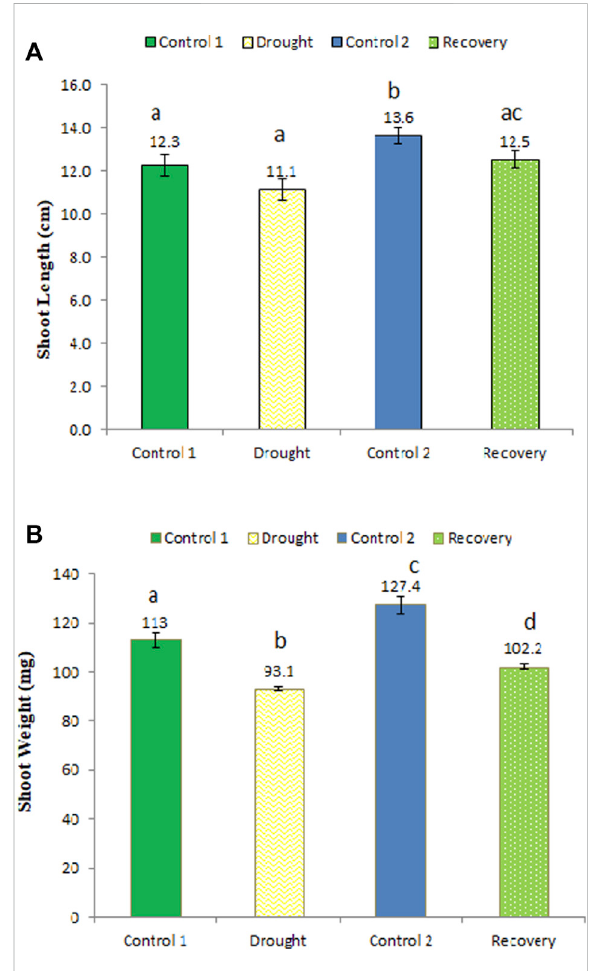
FIGURE 3 Effectofdroughtstressontheshootlength (A) andweight (B) of wheat and its recovery after drought stress. Length is measured in centimeters and weight in milligrams. The data represent the mean of three independent replications. Different letters above the column indicate signi fi cant changes when determined through Tukey ’ s HSD test.